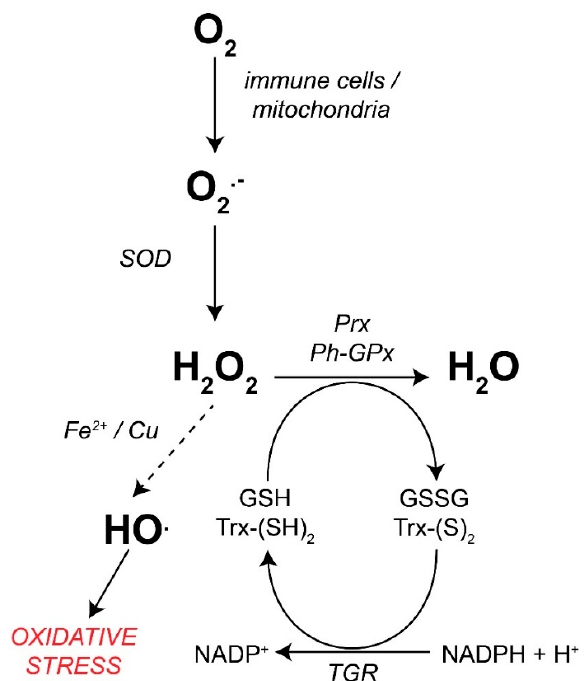
Figure 5. The antioxidant system of parasitic flatworms. Abbreviations: GSH reduced glutathione;